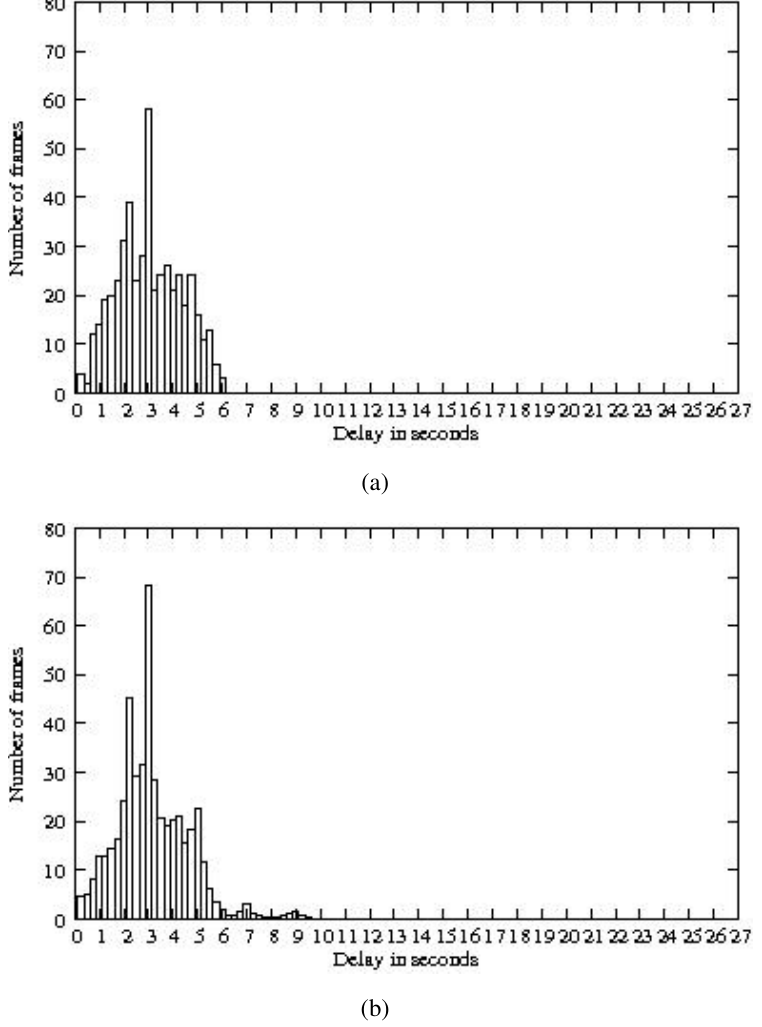
Figure 16. End-to-end delays with: (a) homogeneous traffic; (b) heterogeneous